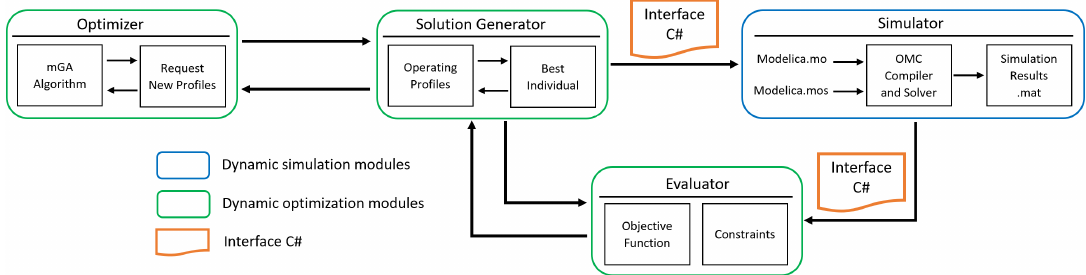
Figure 3. Implementation of the